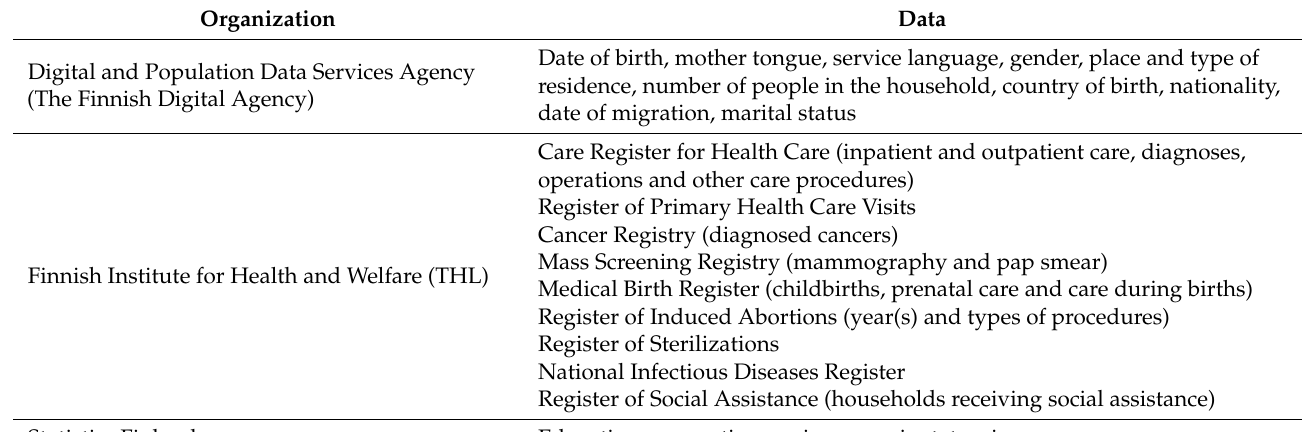
Table 3. Register data available for the Survey on Well-Being among Foreign Born Population (FinMonik) 2018–2019 and the FinSote National Survey of Health, Well-Being and Service Use 2018